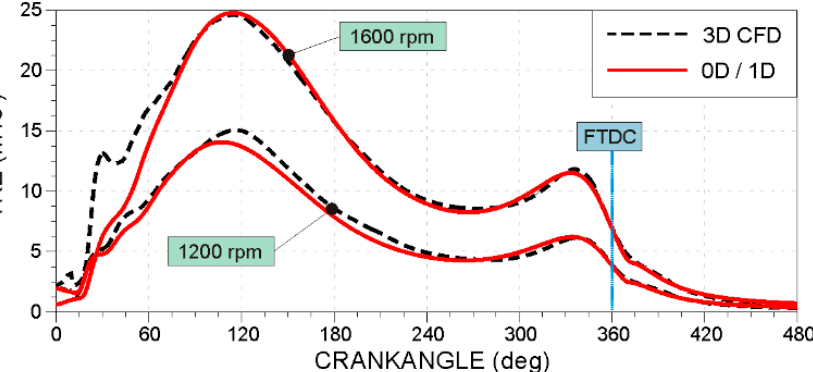
Figure 8. Verification of turbulence model—comparisons of specific turbulent kinetic energies at 1200 rpm and 1600 rpm.